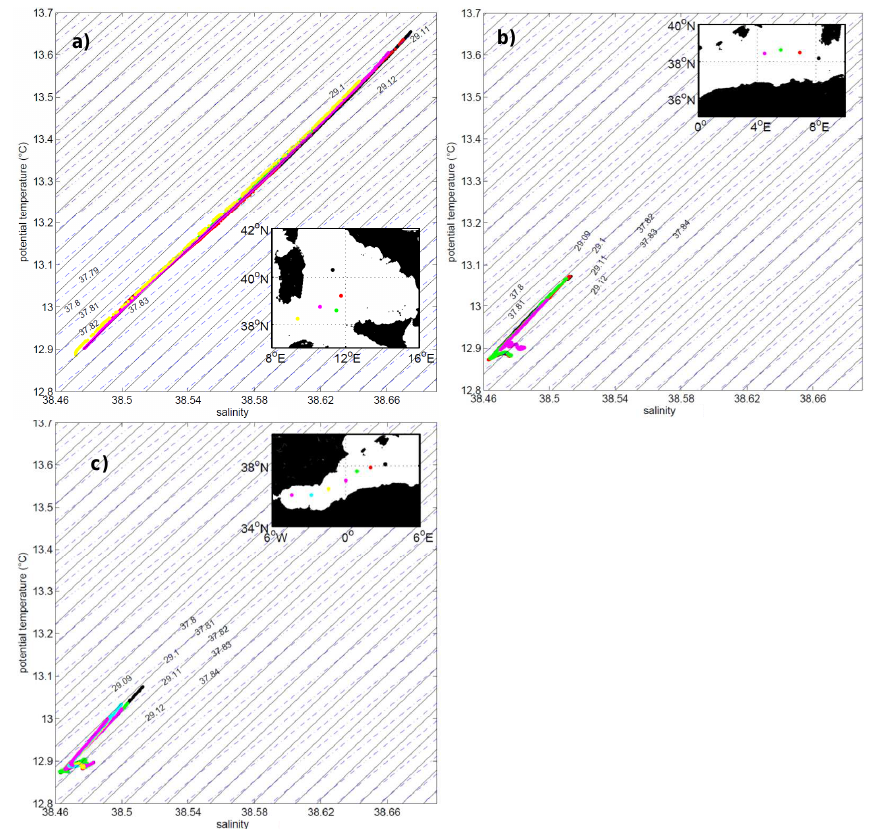
Figure 6. T – S diagrams of M84/3 stations in (a) the Tyrrhenian Sea, (b) the western Mediterranean Sea between the Balearic Islands and Sardinia and (c) the western Mediterranean Sea between Gibraltar and the Balearic Islands. Values from 800m depth down to the bottom are taken into account. The inset panels show the location of the different